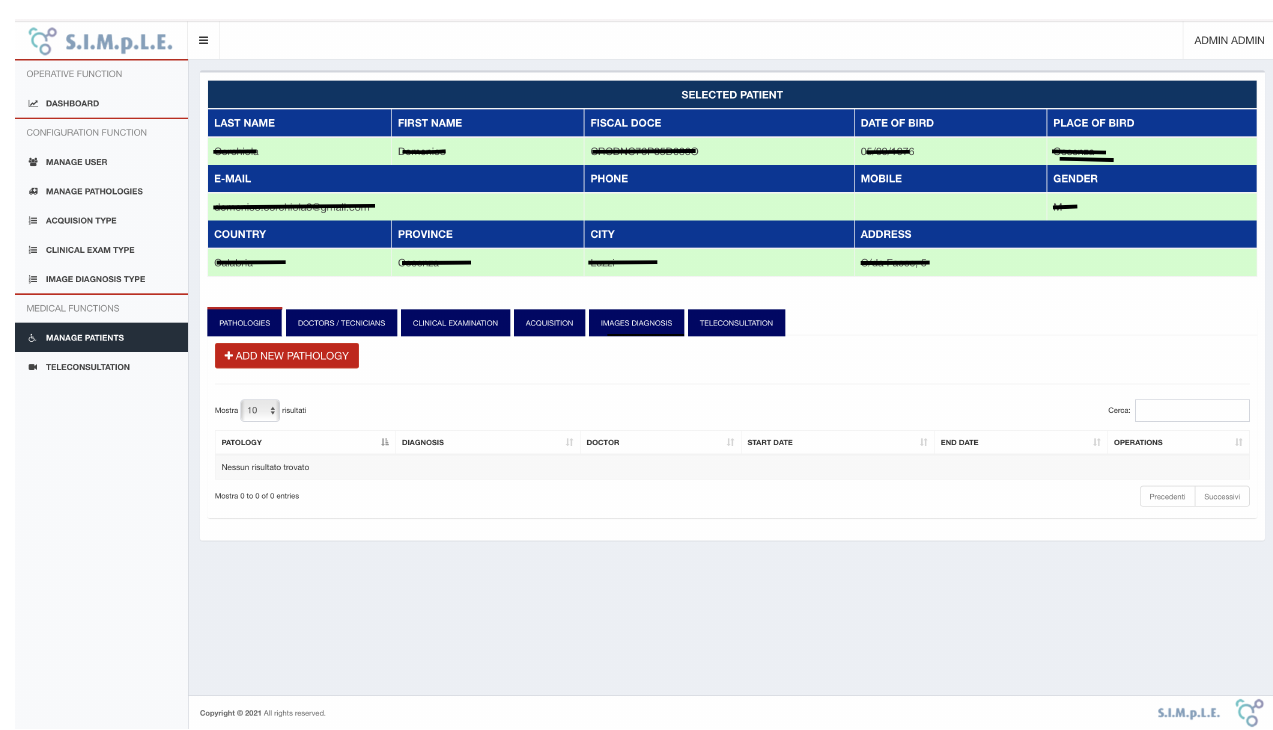
Figure 9. The Patient